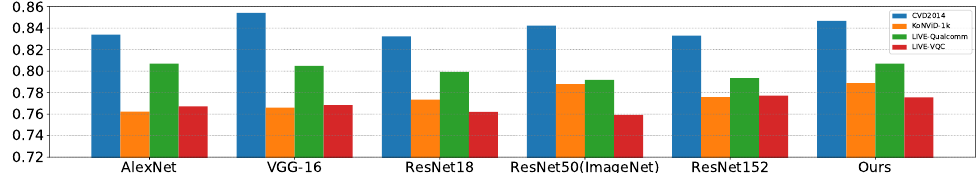
Figure 10. Mean SROCC performance after replacing different 2D feature extractors, including AlexNet, VGG-16, ResNet18, ResNet50 (pre-trained on ImageNet), ResNet152, and ResNet50 fine- tuned on